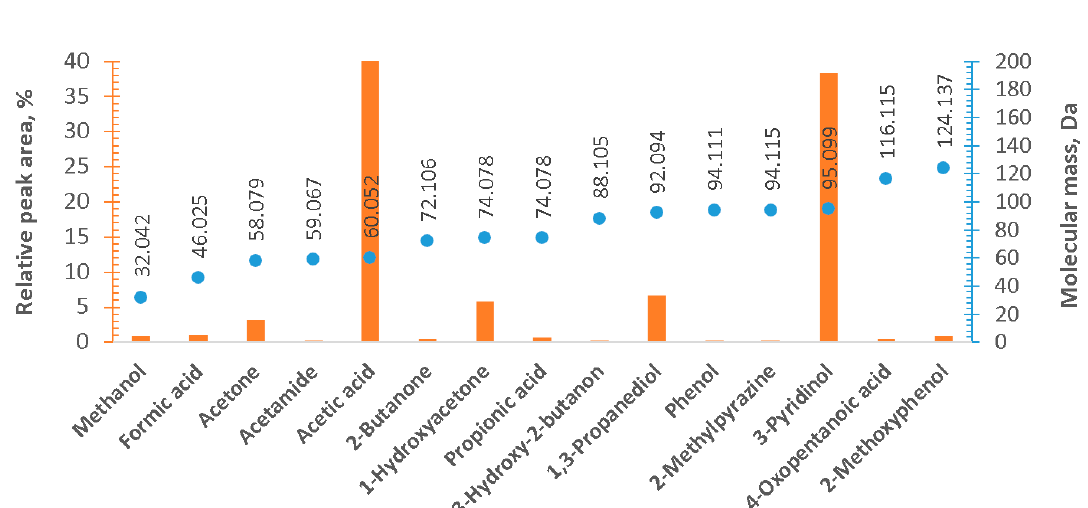
Figure 2. Qualitative results of the gas chromatography-mass spectrometry (GC-MS) analysis. Relative peak area (area of an individual peak with respect to the total area of all peaks)—bar graph, with the axis on the left-hand side (orange). The molecular mass of each of the detected compound—axis on the right-hand side. Official IUPAC Names and respective masses from the Royal Society of Chemistry database.